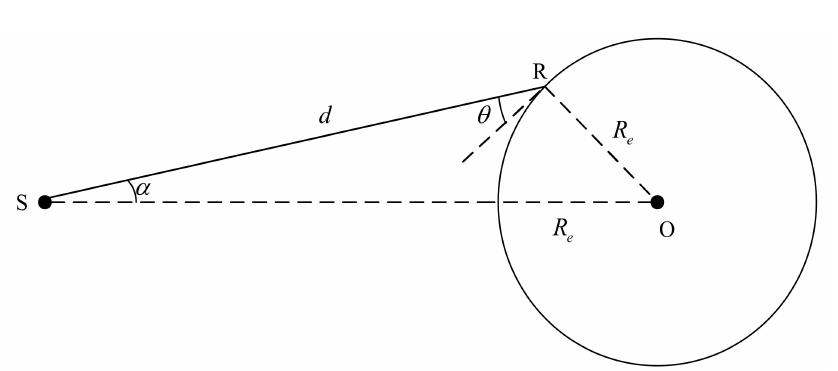
Figure 4. Free space propagation of satellite